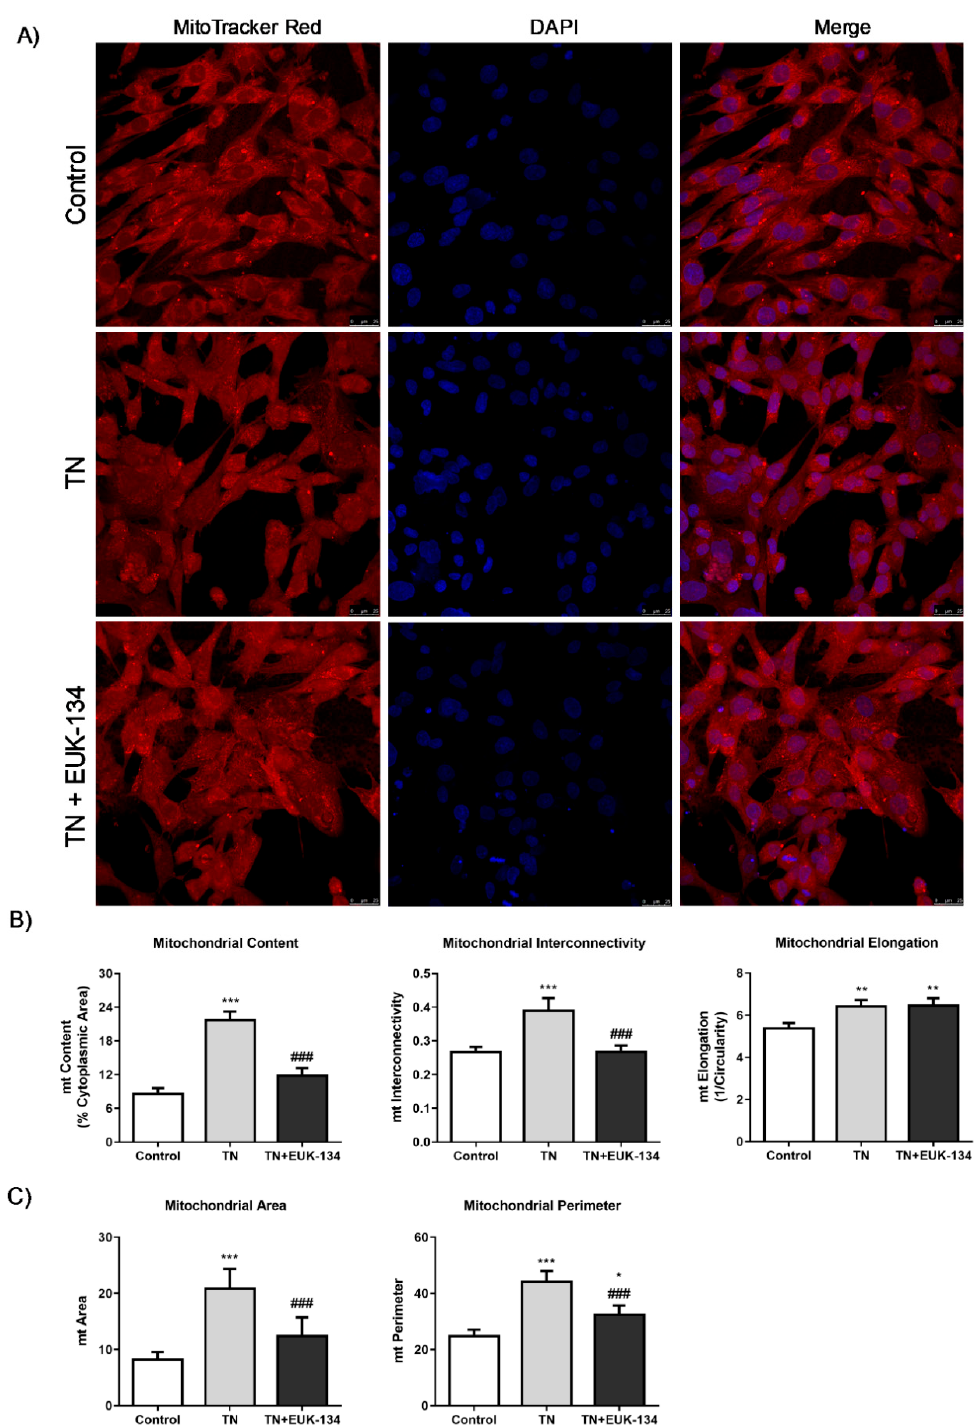
Figure 5. Mitochondrial morphological parameters of tunicamycin-treated cells with or without EUK-134. ( A ) Representative images of fixed human skeletal muscle myoblast stained with MitoTracker Red CMXRos. Images captured using 63 × / 1.4 oil immersion objective. Scale bar = 25 µ m. ( B ) Mitochondrial content as % of cytoplasmic area, mitochondrial interconnectivity expressed by the ratio of mitochondrial area / perimeter, and mitochondrial elongation expressed by 1 / circularity. ( C ) Mitochondrial fragmentation propensity described by mitochondrial area and perimeter. Data represent the mean ± SEM ( n = 100 cells per group). * p ≤ 0.033, ** p < 0.002, and *** p < 0.001 against vehicle control or tunicamycin alone